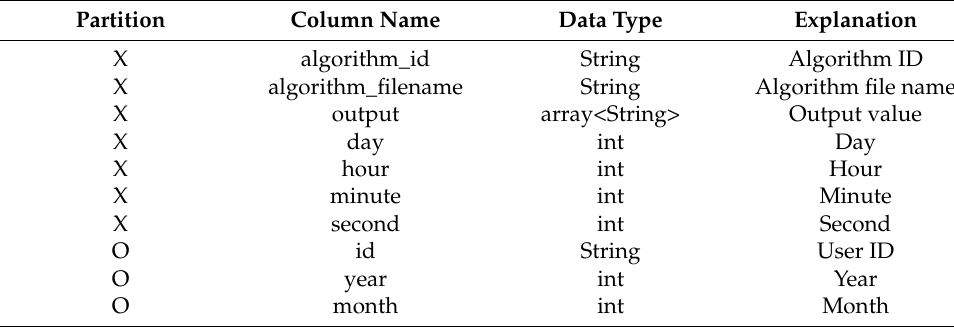
Table 2. The table structure of